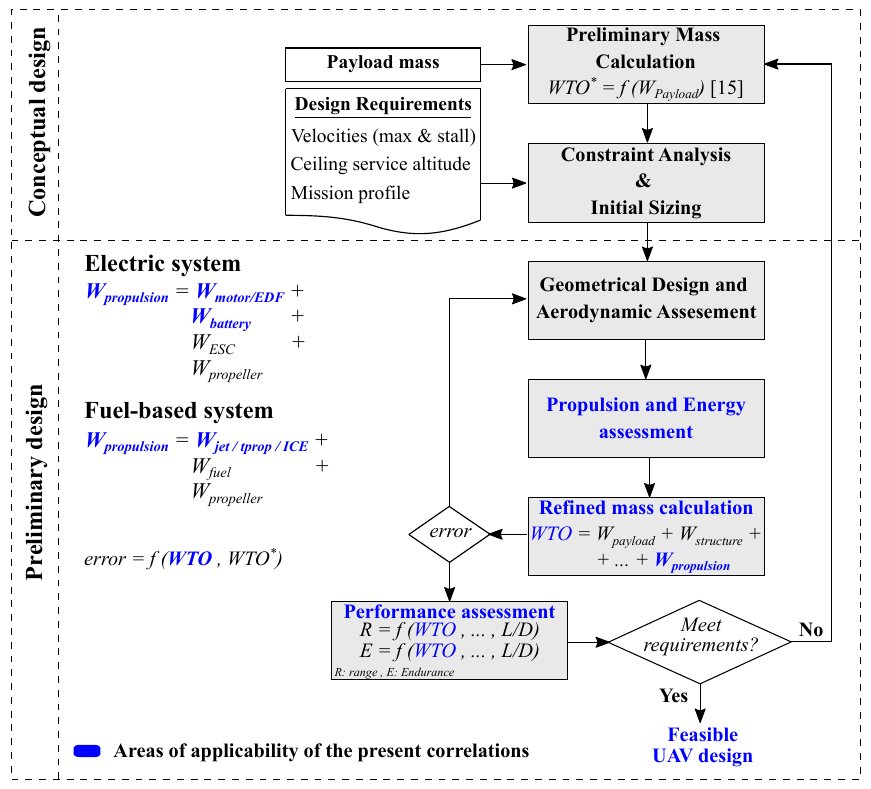
Figure 2. Schematic flowchart for implementation of empirical